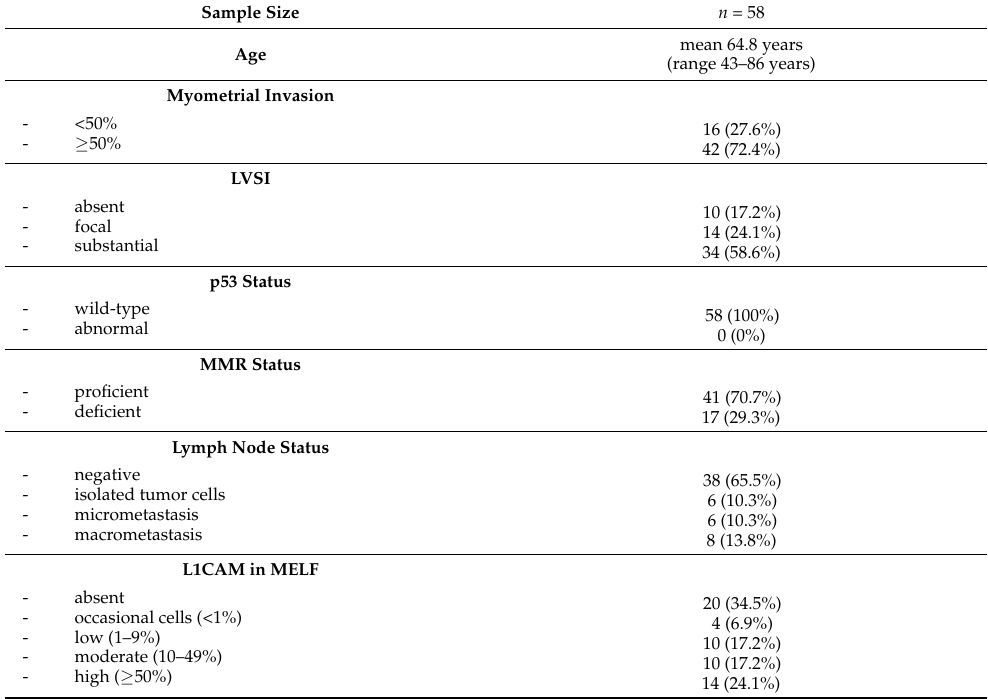
Table 1. Summary of clinical, histological and immunohistochemical